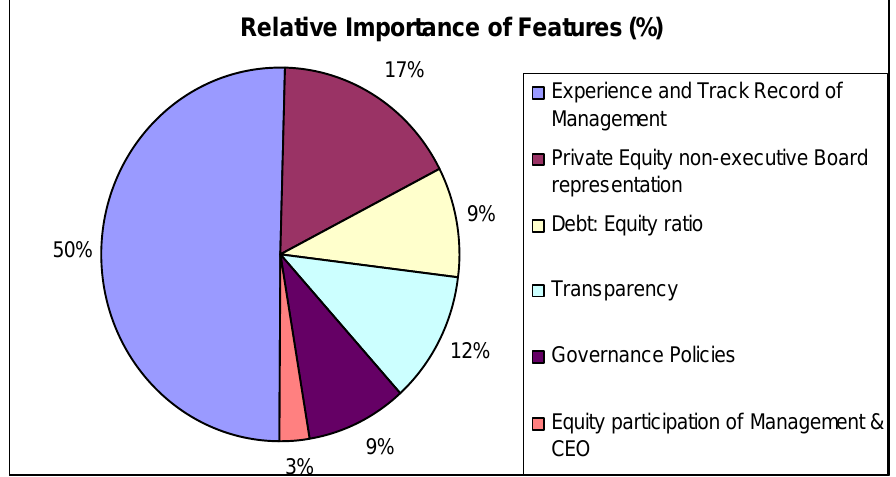
Figure 1: Relative importance of